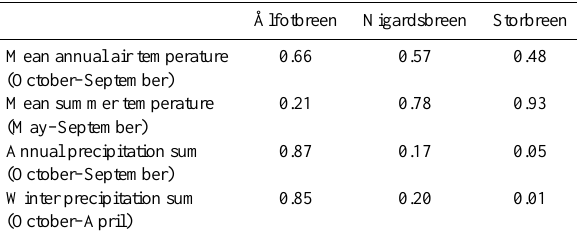
Fig. 10. Modelled monthly discharge rates and their contributing sources for ˚Alfotbreen, Nigardsbreen and Storbreen averaged for the period 2001-2010. Data for the contributing sources represent the mean of the best 100 model runs.